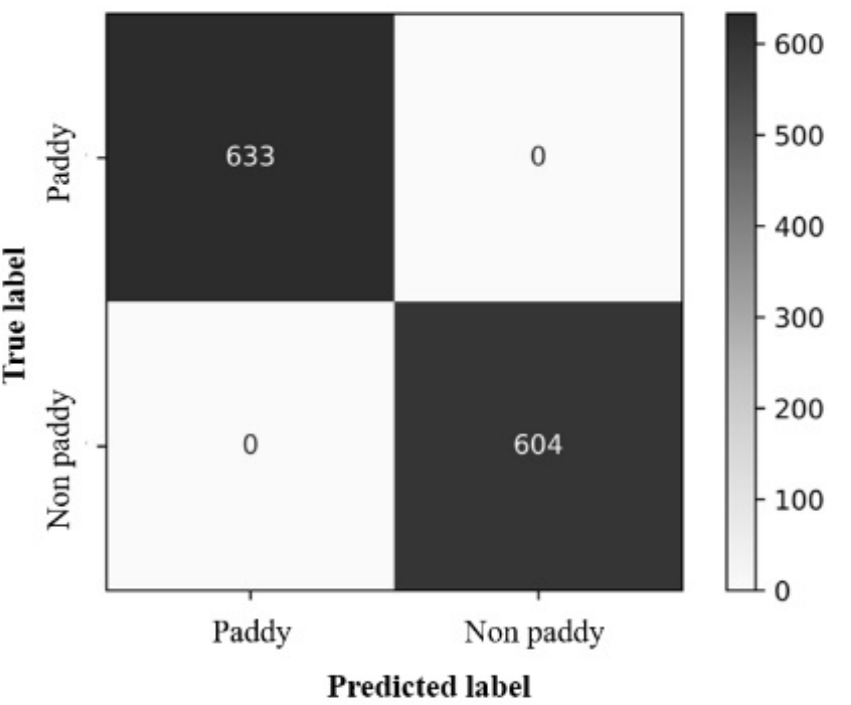
Figure 12. Confusion matrix of the paddy rice kernels.